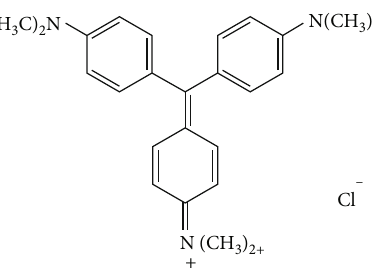
Figure 1: Crystal violet molecular